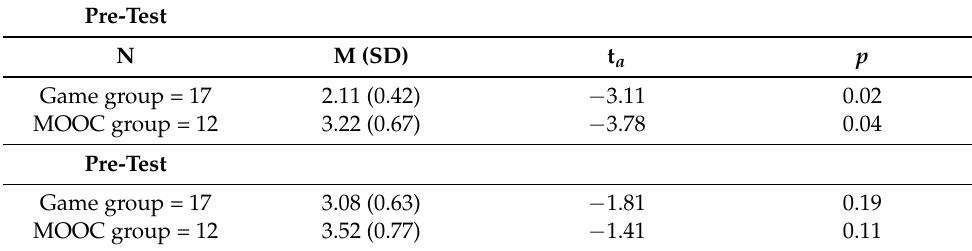
Figure 6. Mean of each UX dimension from UEQ. Table 3. Perceived knowledge evaluation in groups using iTrain game vs. iTrain